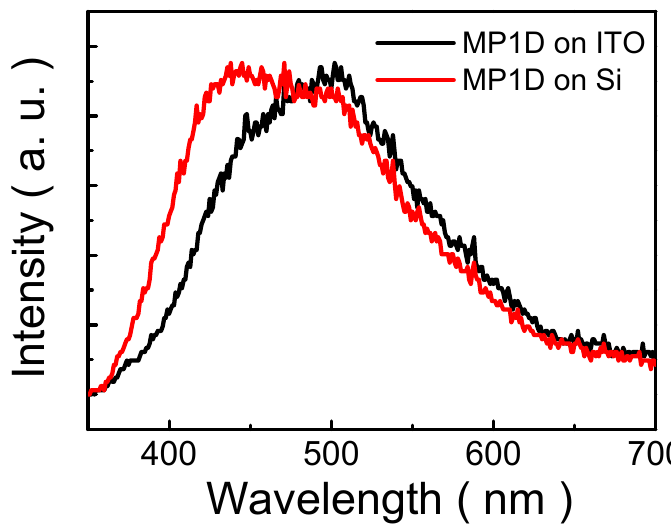
Figure 3. Room temperature PL spectra of MP1D films on ITO and Si substrates.